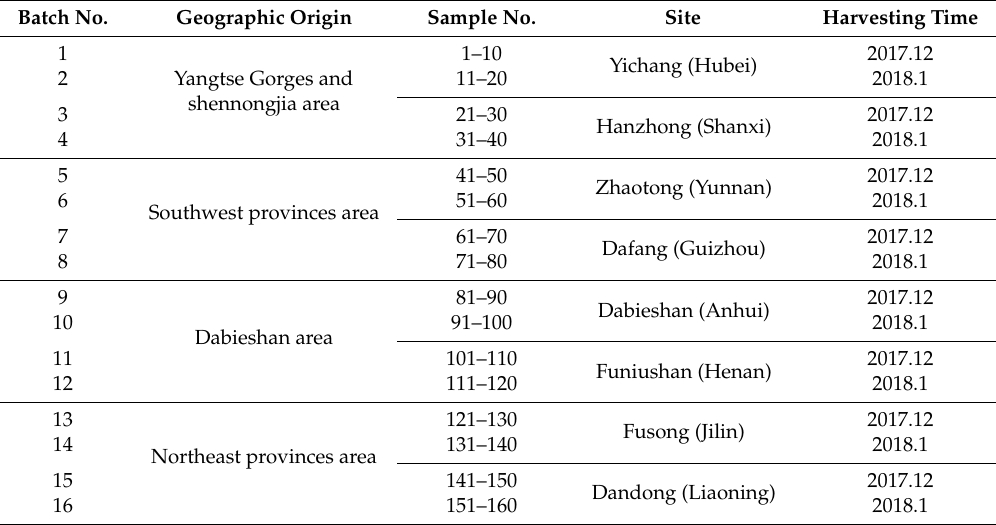
Table 1. The sampling regions of G.